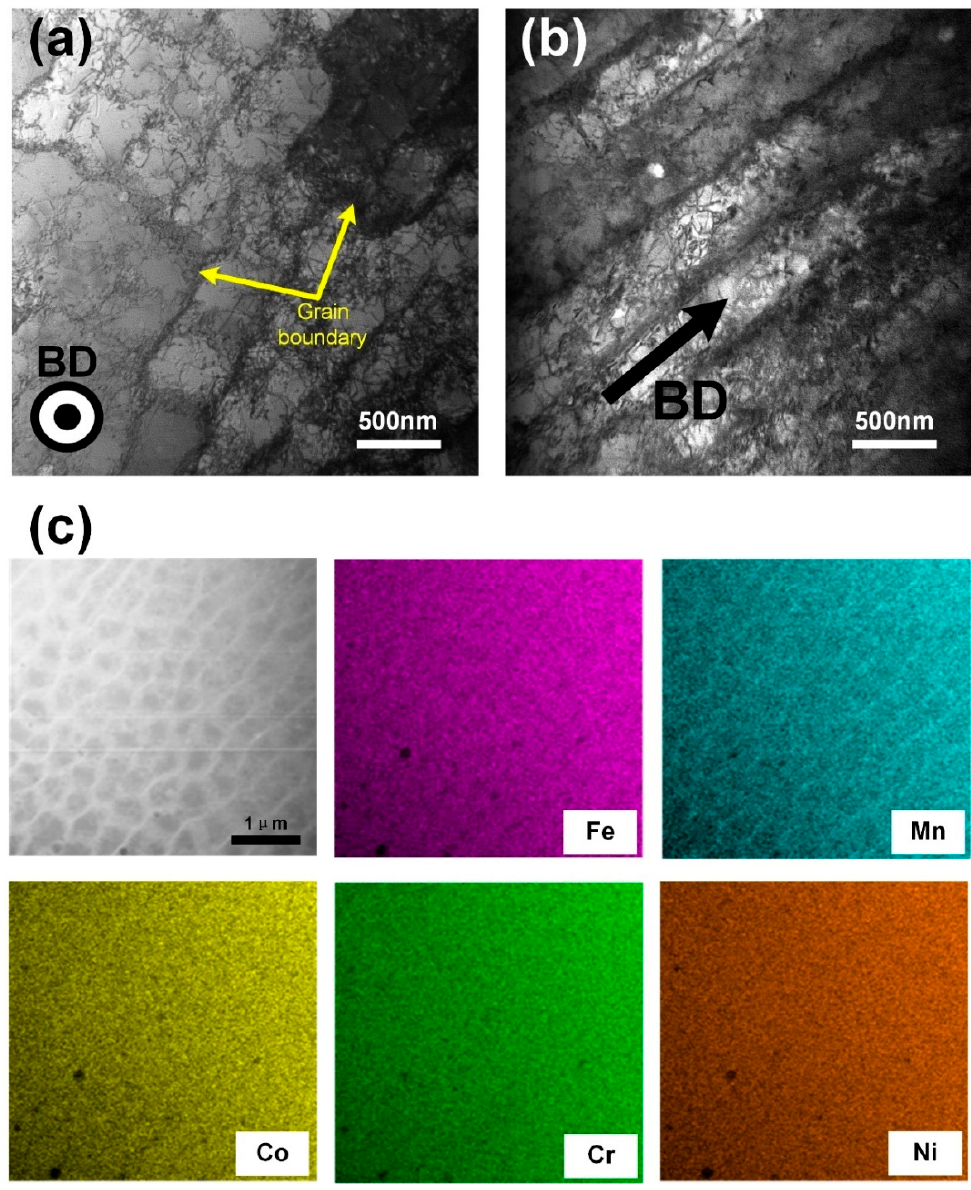
Figure 5. TEM bright field images of the cellular-dendritic sub-structures from ( a ) top surface XOY plane and ( b ) cross section XOZ plane. ( c ) STEM image and elemental distribution maps of the sub-structures.